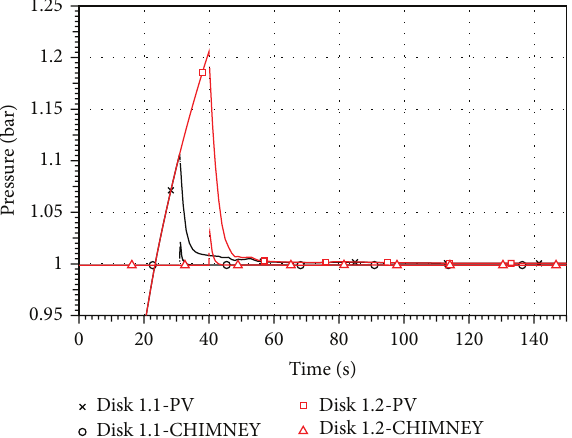
Figure 12: Failure of opening of burst disk at 1.1 bar: pressure in the